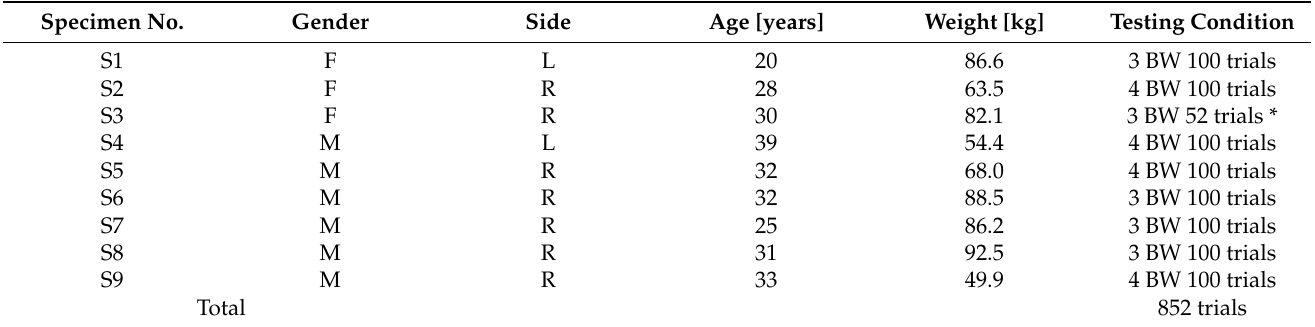
Table 1. Demographic data of the knee specimen